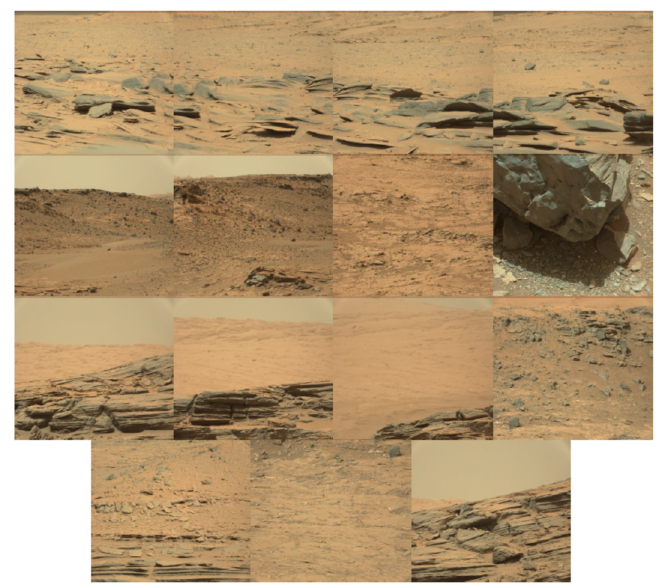
Figure 3. Right Mastcam images.